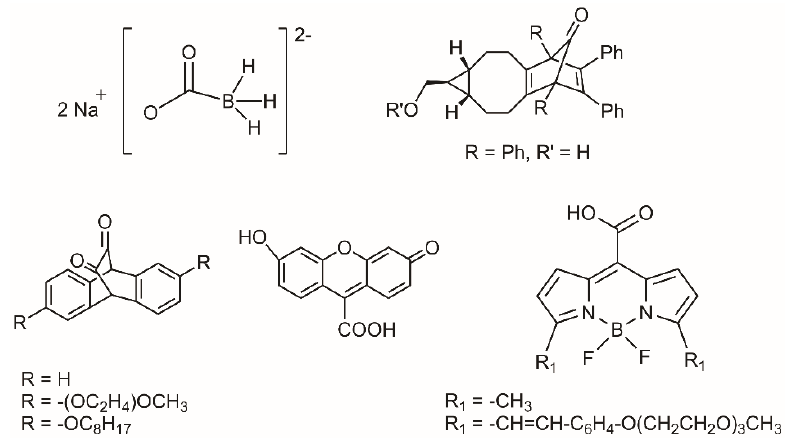
Figure 1. Examples of transition metal-free CO-releasing molecules (CORMs). Spontaneous (top) and visible light-induced (bottom) CORMs.